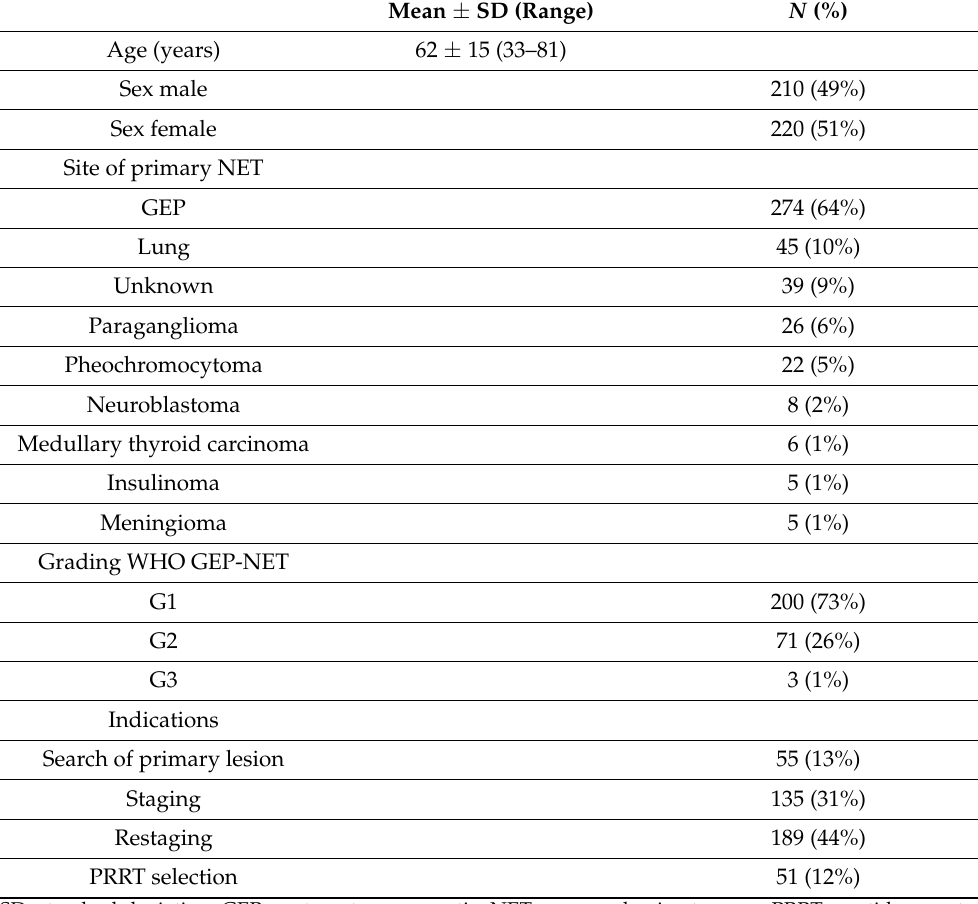
Table 1. The main characteristics of 430 patients